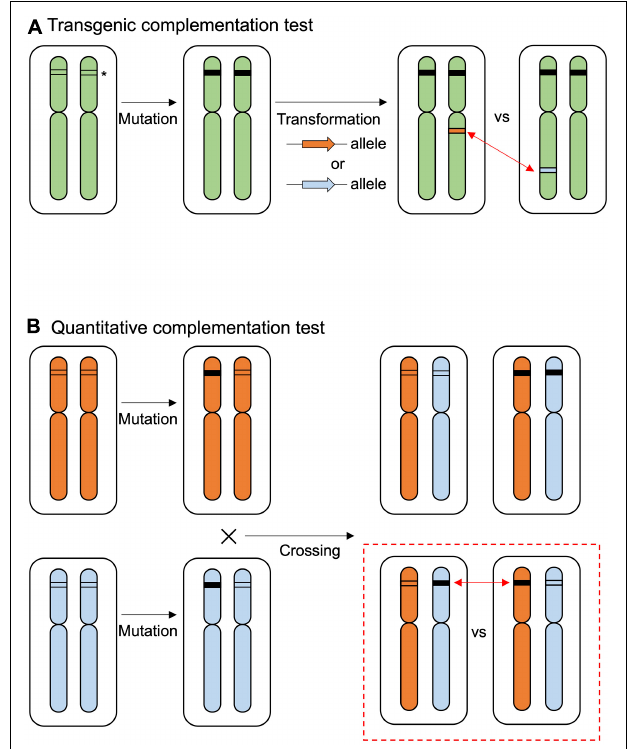
FIGURE 2 | Overview of the complementation tests. (A) The traditional transgenic complementation test compares the effects of inserted alleles (indicated by orange or blue arrows) in the null mutant background. The allelic effect of the target gene is compared from different insertion positions (red two-sided arrows). The asterisk indicates the target gene. The black box at the target gene indicates the mutated sequence. (B) Quantitative complementation test using null mutation of different alleles. Allelic effects are evaluated in the F 1 progenies of heterozygous mutants (red dashed square). The allelic effect of the target gene is compared from the original position in the genome (red two-sided